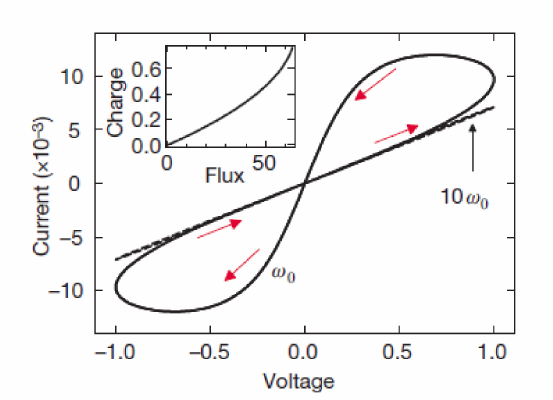
Figure 2 . Typical behavior of Figure 2. Typical behavior of memristors.